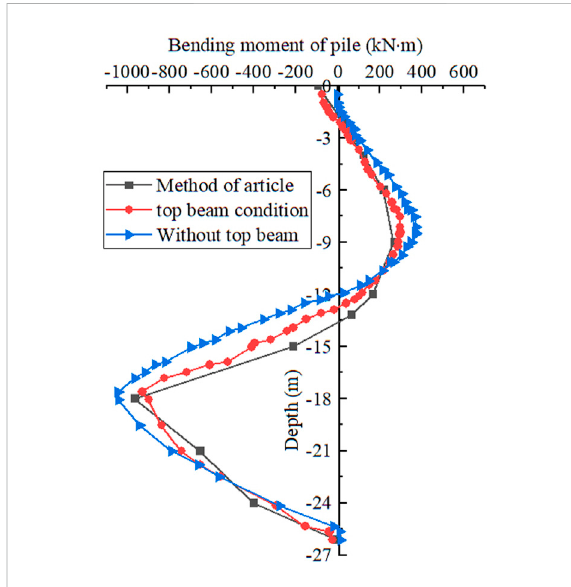
FIGURE 12 Pile body bending moment comparison chart.